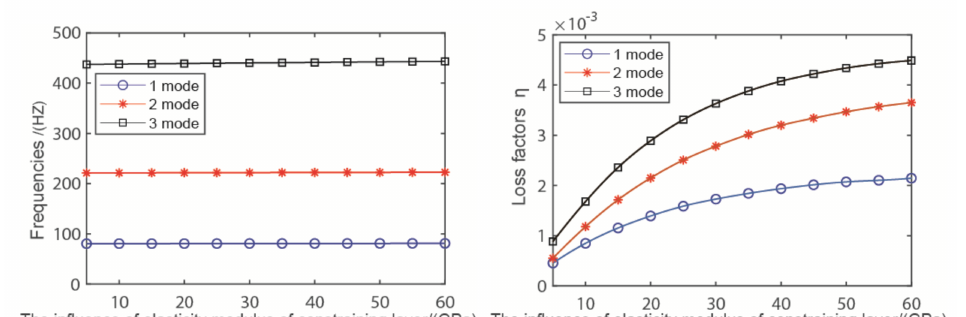
Figure 10. The effect of the elasticity modulus of the constrained layer.